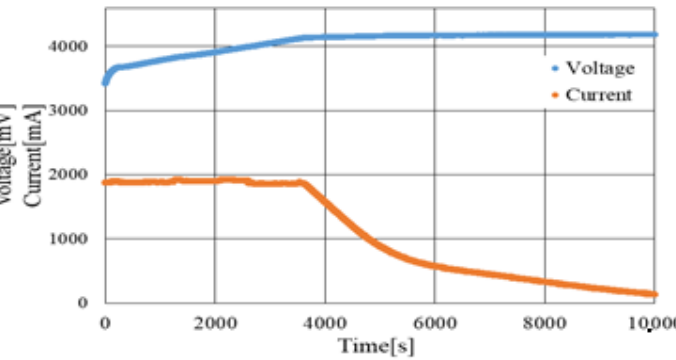
Figure 6. Charging characteristic of Li-Ion during CCCV mode.